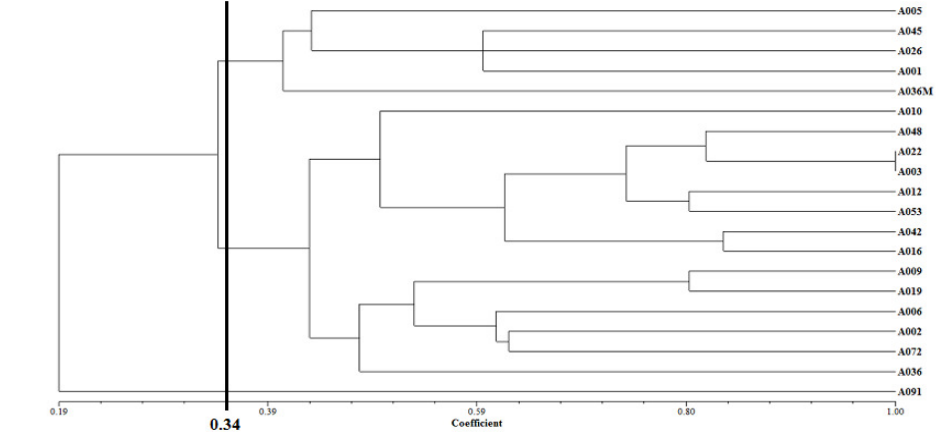
Fig. 3. UPGMA dendrogram constructed from molecular data (SSR Marker Analysis) of 20 Nigerian castor